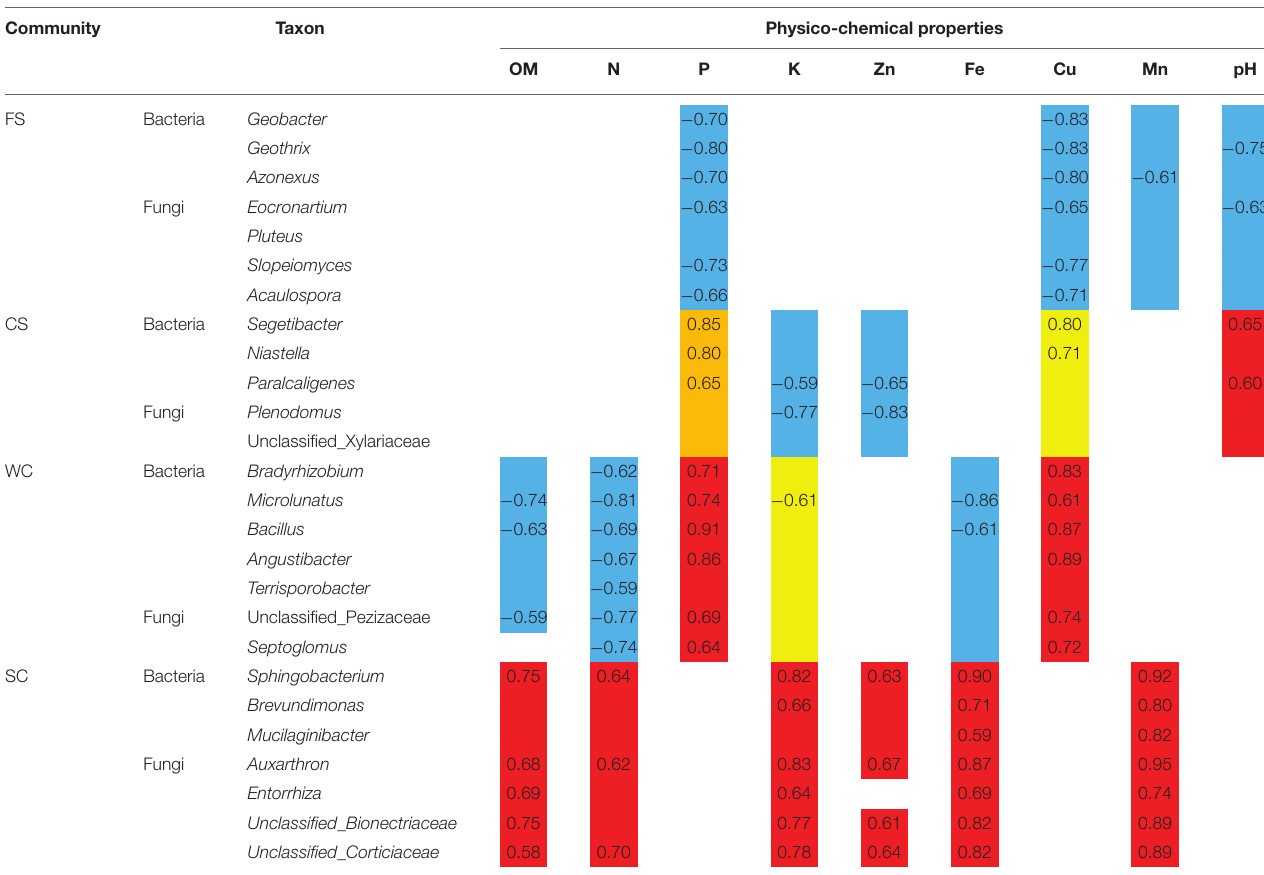
TABLE 4 | Relationships between species and soil physico-chemical properties.